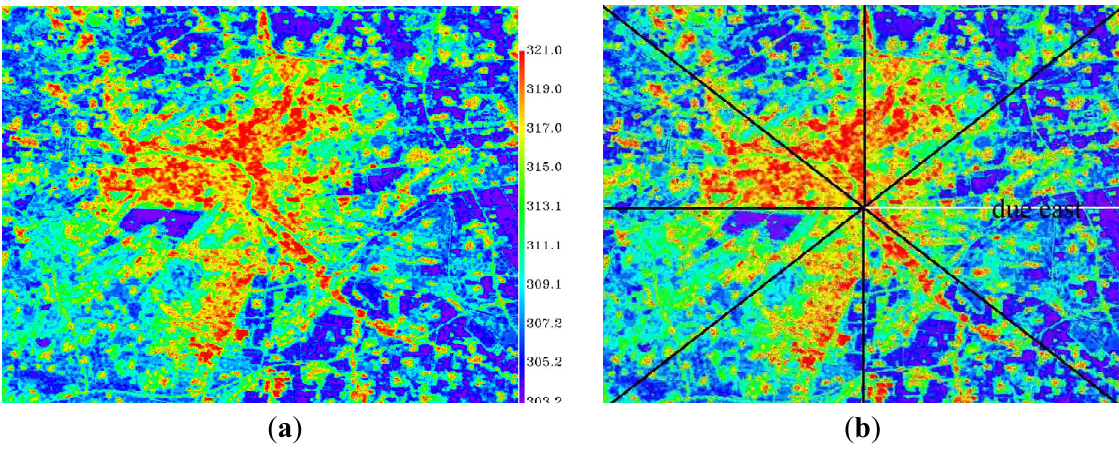
Figure 4. Land surface temperature (LST). ( a ) LST inversed using SCA method; ( b ) UHIs distribution in eight transects.